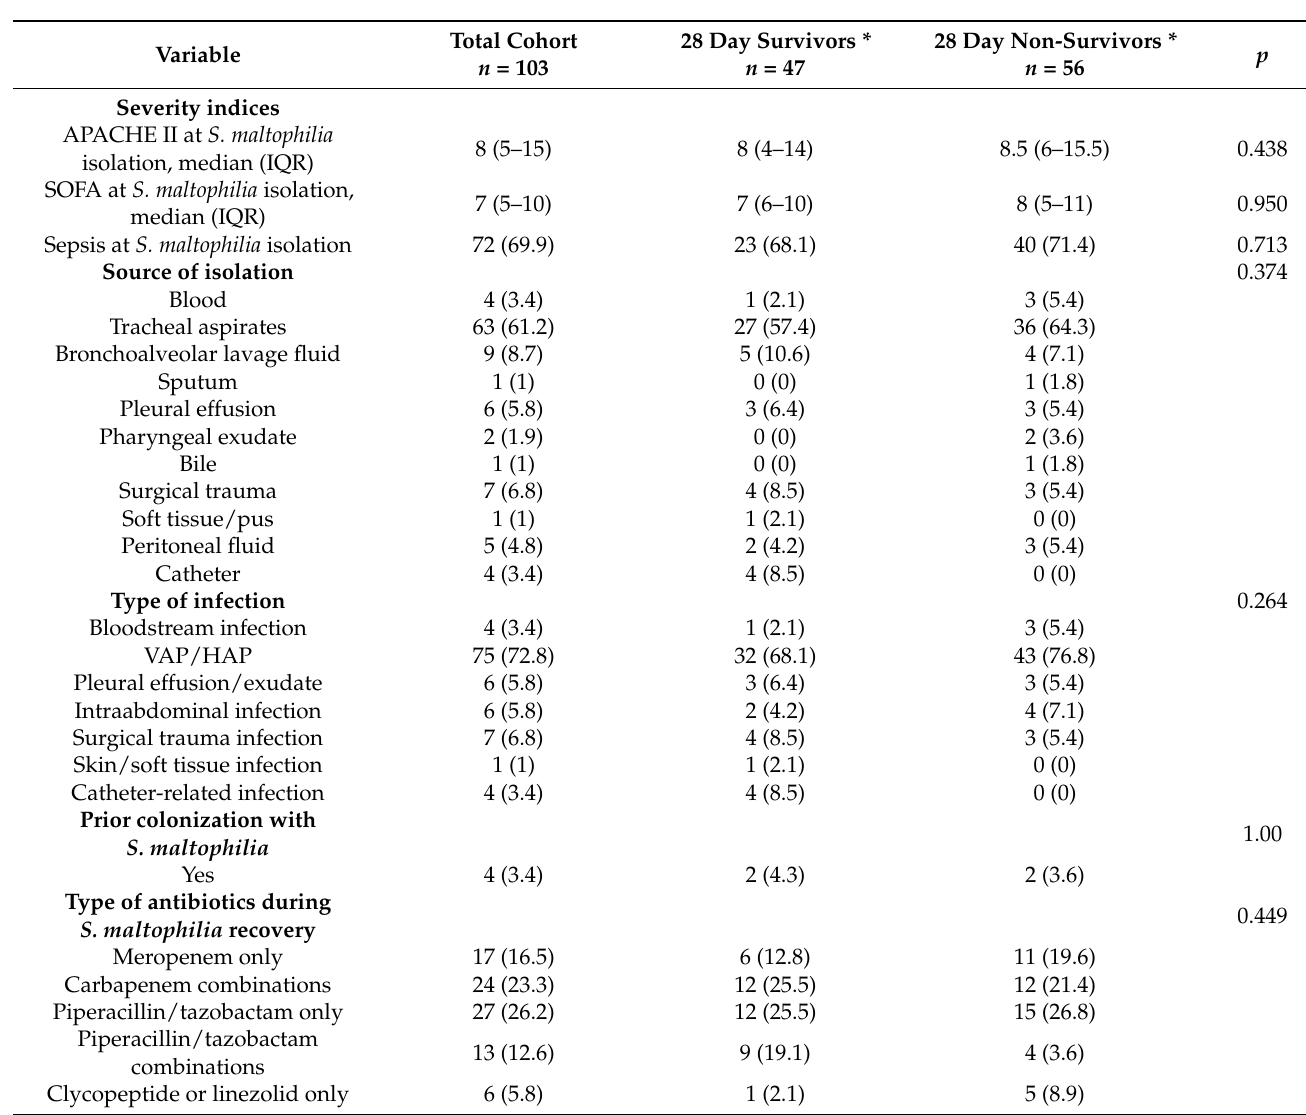
Table 2. Clinical characteristics relating to the infection caused by Stenotrophomonas